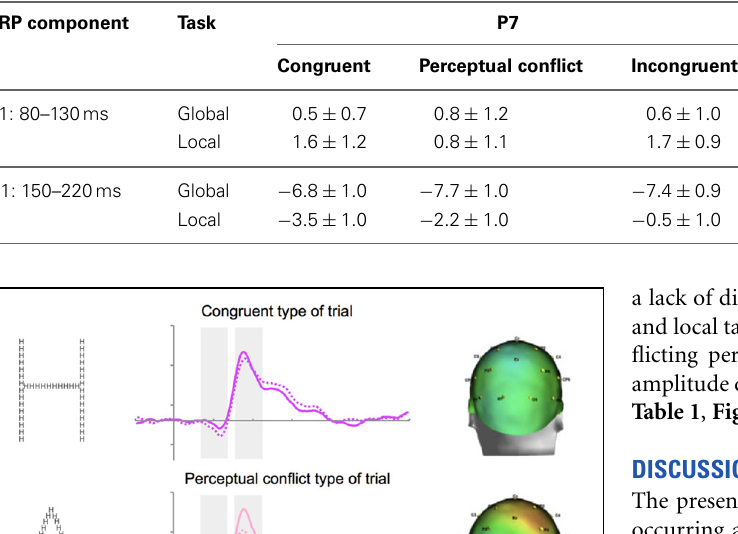
Table 1 | Mean amplitudes for the different ERP components elicited on P7 and P8 electrodes according to the interference effect during the different tasks ( ± standard deviation).